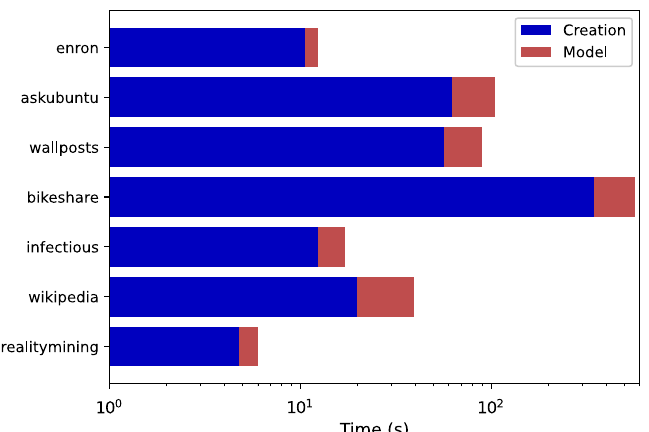
Fig. 10 Creation time for hybrid data structure with predictive compound slices. The time to train the predictive model adds a small overhead to the creation time for the hybrid structure without the predictive